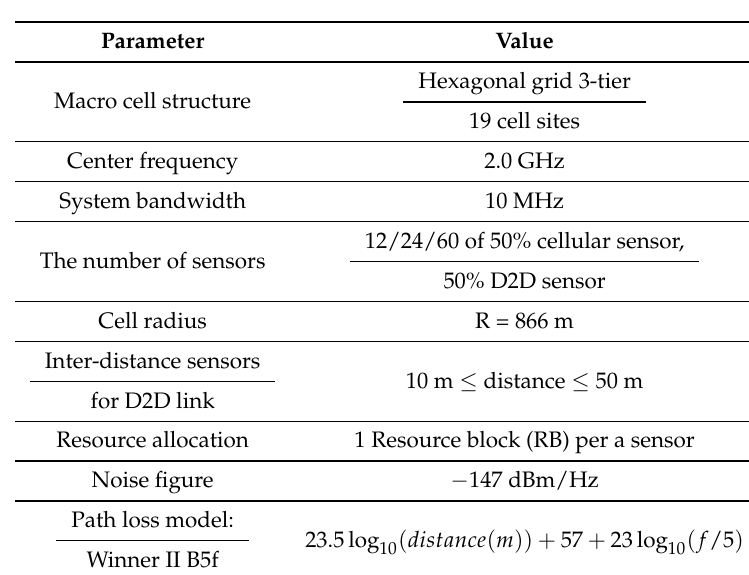
Table 4. Simulation